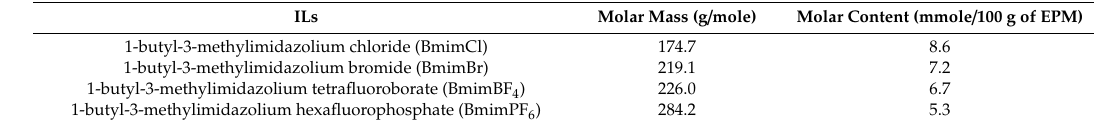
Table 2. Ionic liquids (ILs) used in this study.